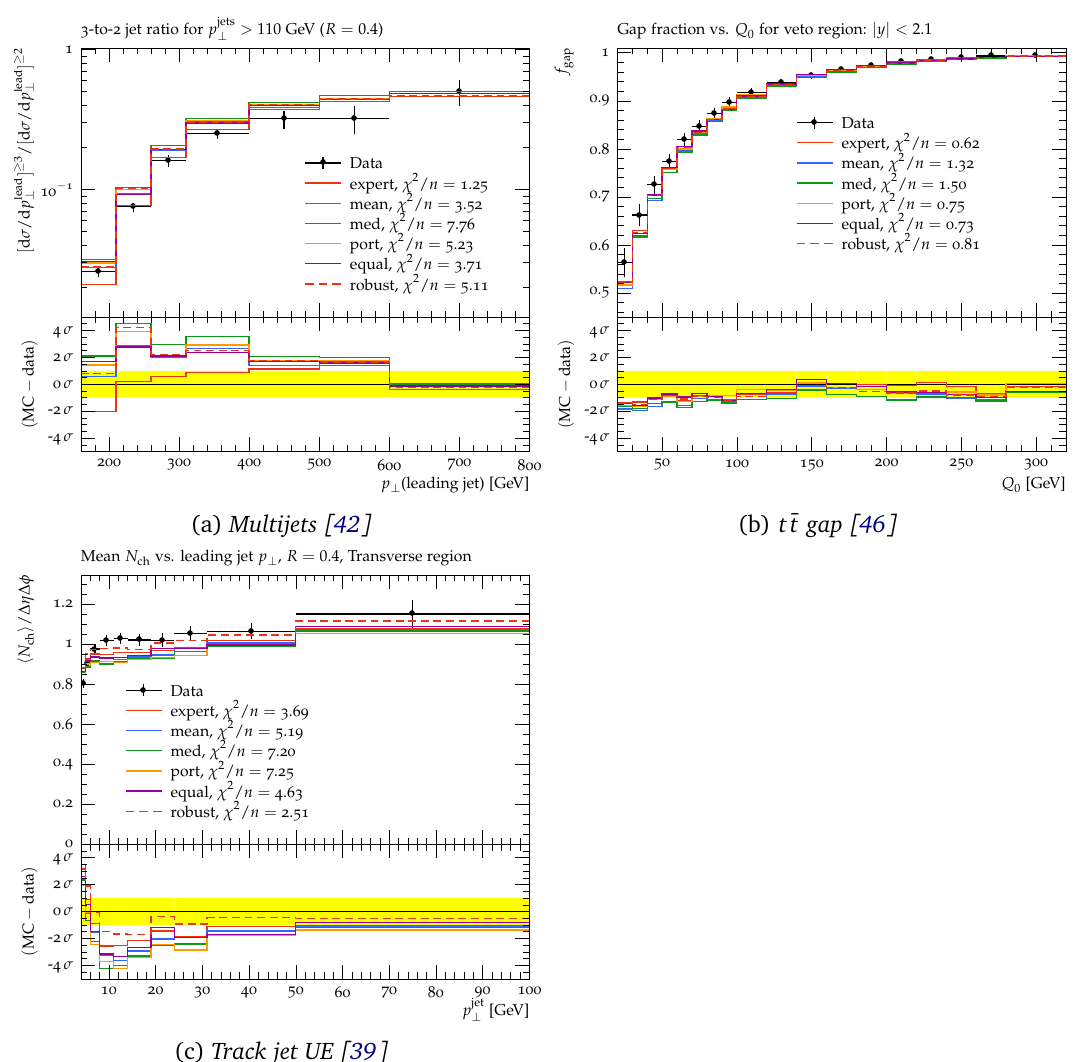
Figure 9: Examples of A14 observables and their χ 2 tuning approach performs worse than the expert’s hand